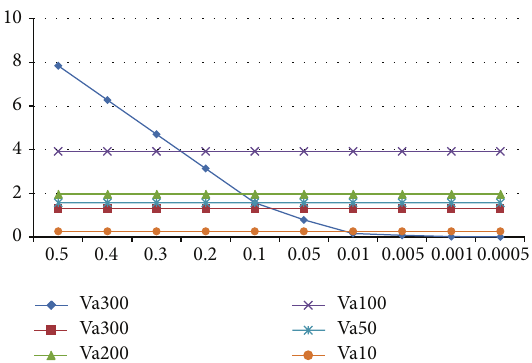
Figure 8: System utilization depending on the REST web server performance.